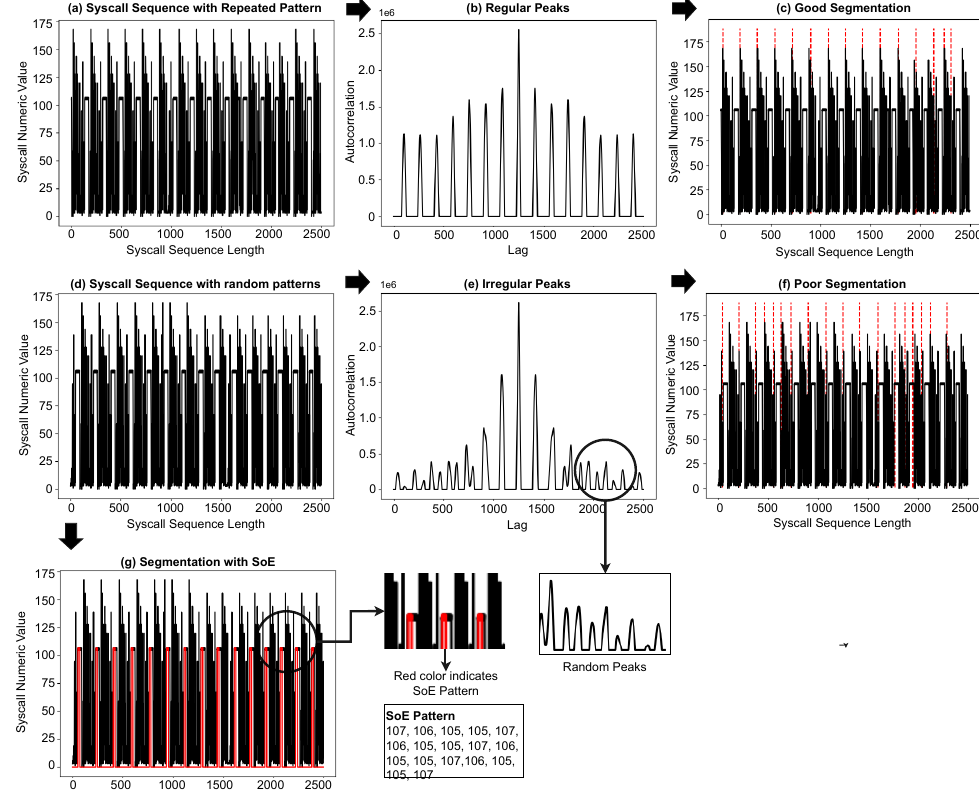
Figure 5. ( a – c ) show a sample of the UNM-LPR syscall sequence, its autocorrelation, and segmenta- tion, respectively. The dotted red lines in ( c , f ) show the segmentation boundaries determined using positions of peaks from autocorrelation; ( d – f ) show the same stages for a noisy UNM-LPR syscall sequence sample, while ( g ) shows boundaries determined using the SoE pattern shown in red; ( g ) shows that the SoE pattern provides better segment boundaries for a noisy syscall sequence for which the autocorrelation method did not perform